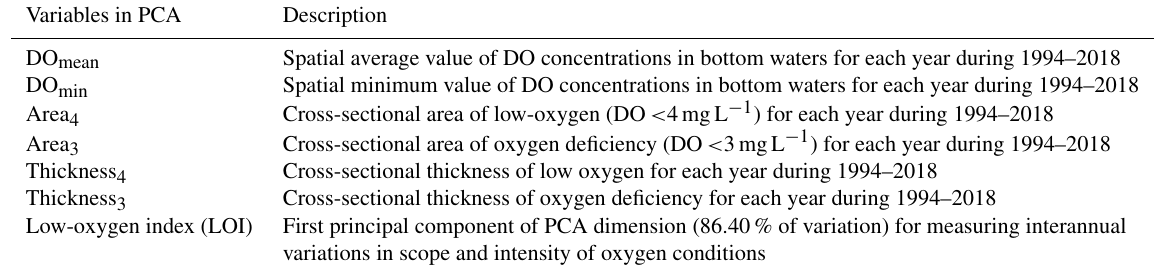
Table A1. Description of variables in the principal component analysis (PCA).